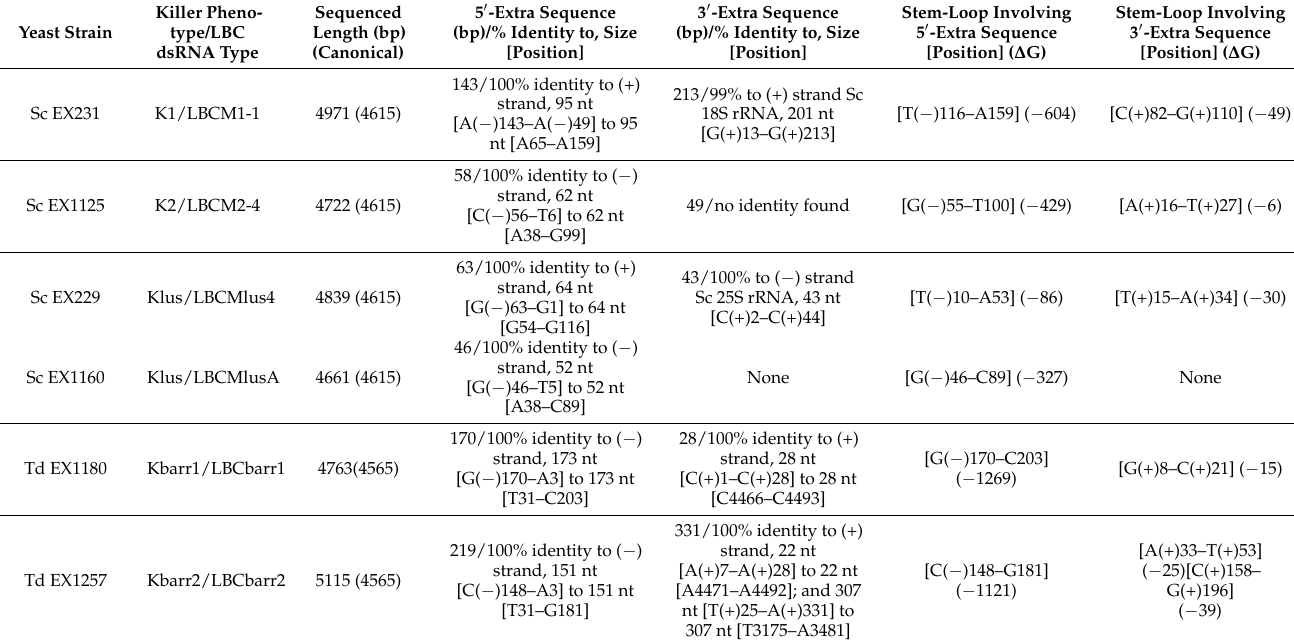
Table 1. Yeast strains and characteristics of the V-LBC genomes sequenced by